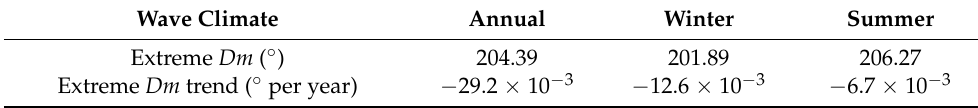
Table 4. Average extreme Dm and its trends between